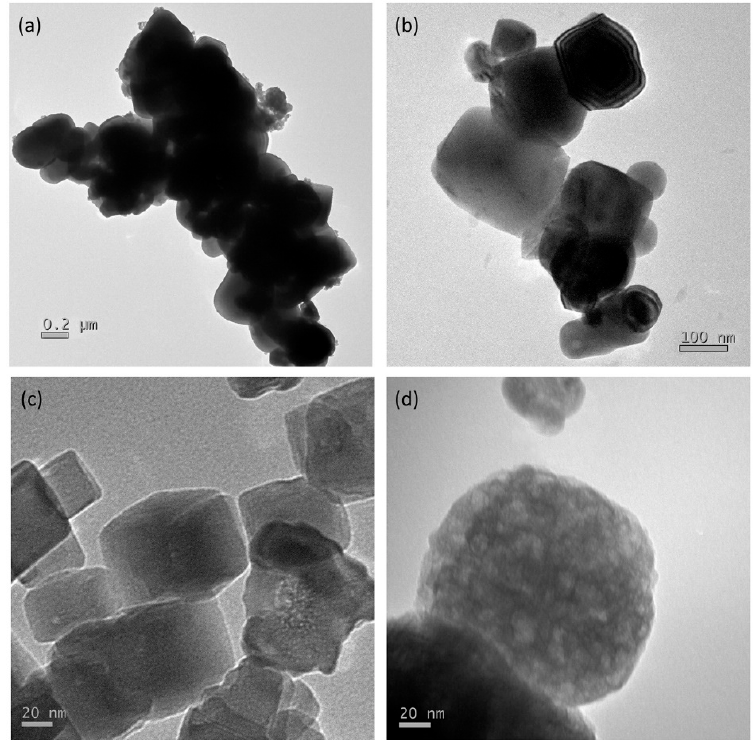
Figure 3. TEM images of Rh-doped SrTiO 3 catalysts ( a ) SS-STO2Rh ( b ) HT-STO2Rh ( c ) MW-STO2Rh-A ( d ) MW-STO2Rh-T.